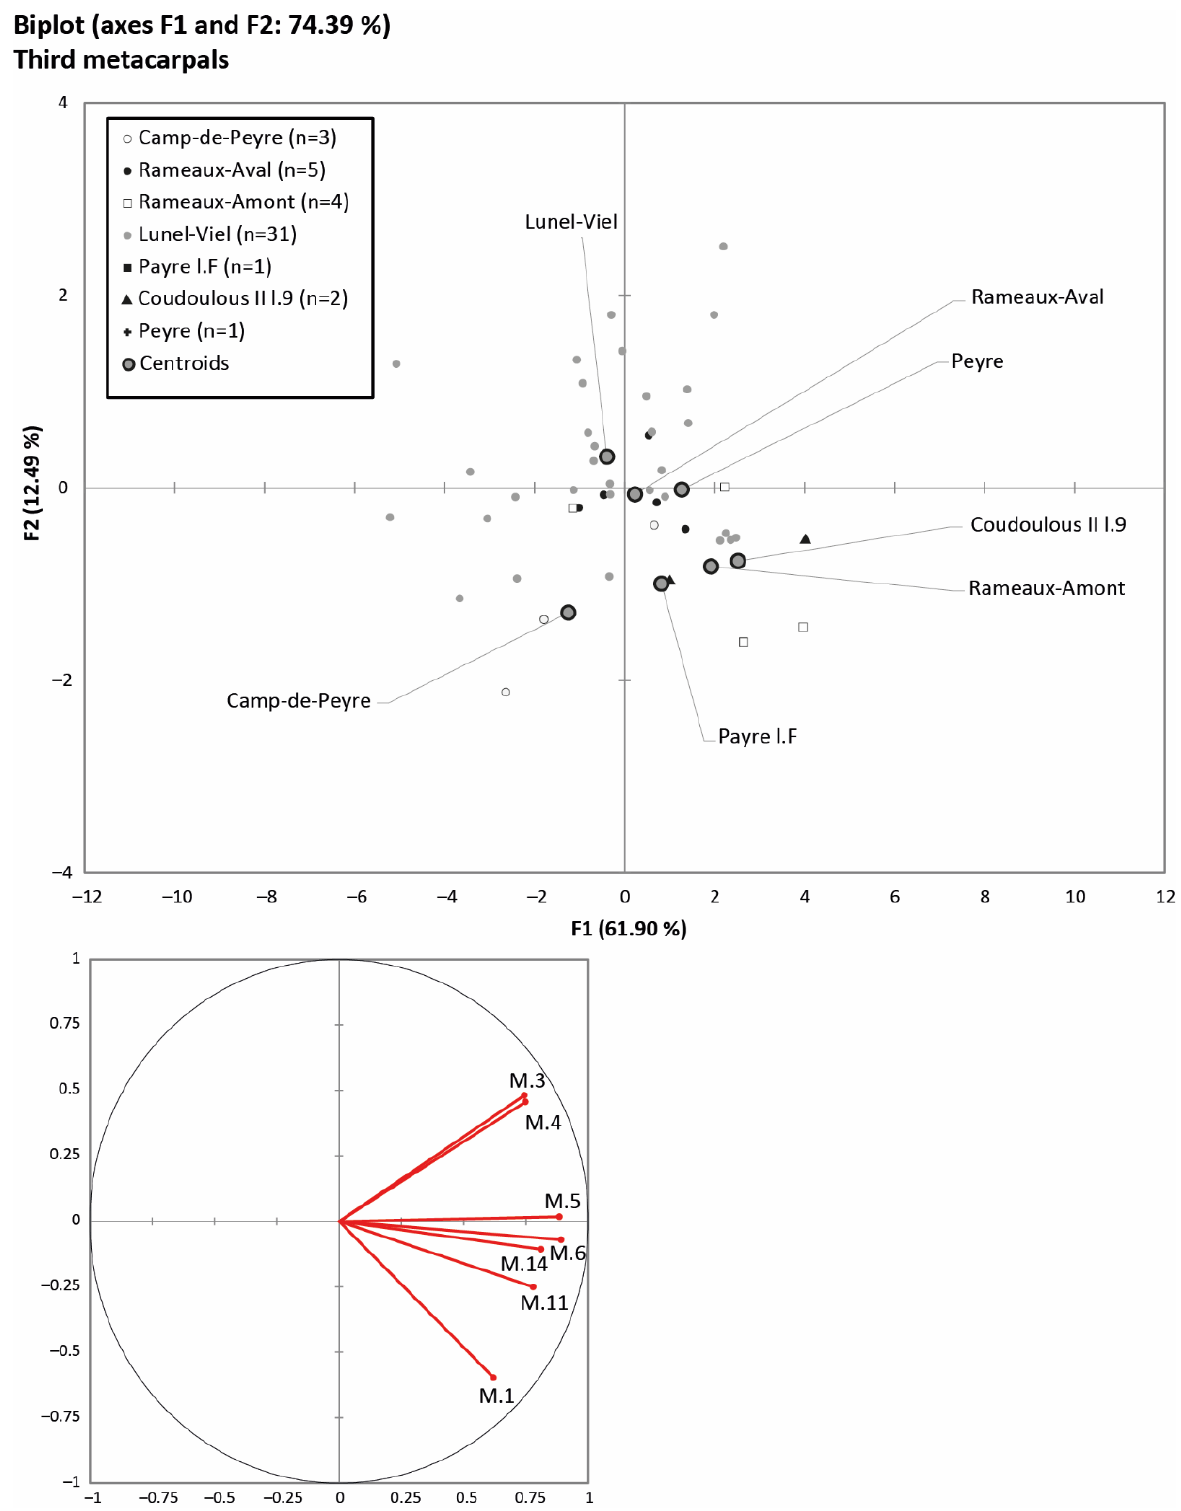
Figure 5. Principal component analysis (PCA) with measurements of the third metacarpal of Southern Middle and Late Pleistocene horses from the caballoid lineage. The correlation circle illustrates the contribution of each variable. M. 1: Maximal length, M. 3: Breadth at the middle of the diaphysis; M. 4: Depth of the diaphysis at the same level; M. 5: Proximal breadth; M. 6: Proximal depth; M. 11: Distal articular breadth; M.14: Greatest depth of the medial condyle. The large dots correspond to the centroid of each cohort. Camp-de-Peyre: E. m. campdepeyri ; Rameaux-Aval and Amont: E. mosbachensis ; Lunel-Viel: E. m. palustris ; Payre l.F: E. mosbachensis ; Coudoulous II l.9: E. mosbachensis ; Peyre: E. caballus .